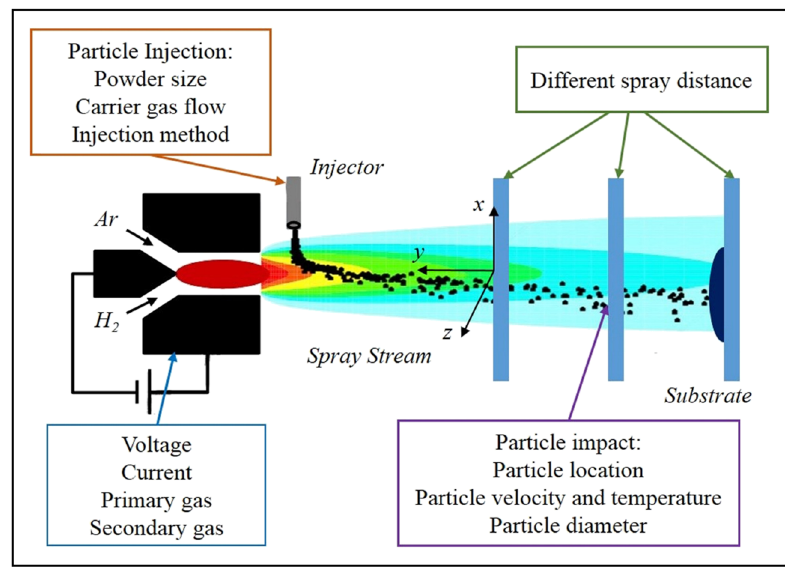
Figure 10: Schematic illustration of the PS process [ 72 ] . Copyright 2020,